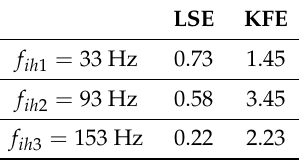
Table 2. TVE versus interhamonic components for N = 144 samples & SNR = 150